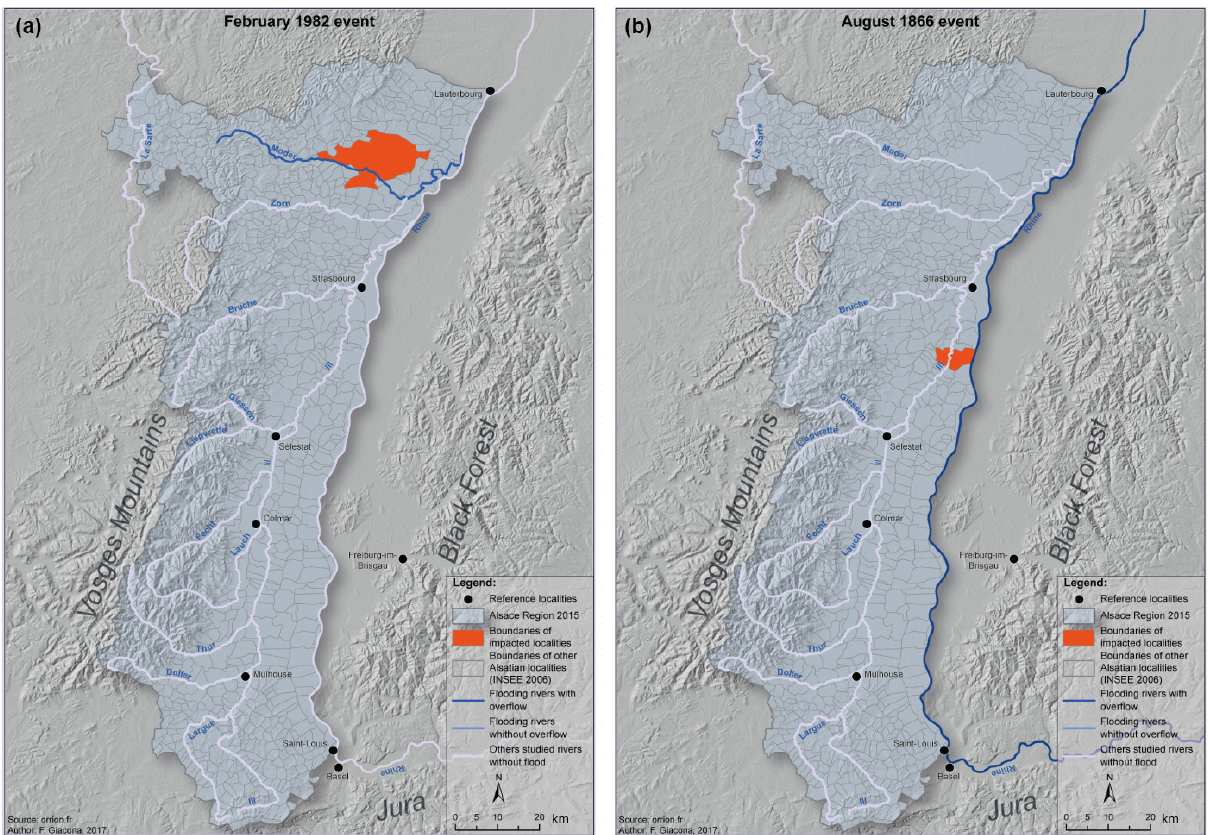
Figure 3. Maps of specific class I events. (a) February 1982 event. T configuration (Alsatian tributaries of the Rhine River alone). Extent score: 0. Damage score: 1. Overflowed Moder River caused functional damage and impacted one municipality. This event is attributed to snow melting/thaw and to long-lasting rainfall. It is known from one source. (b) August 1866 event. R configuration (Rhine River alone). Extent score: 0. Damage score: 0. Overflowed Rhine River caused environmental, functional, and material damage and impacted one municipality. This event is attributed to long-lasting rainfall and is known from 43